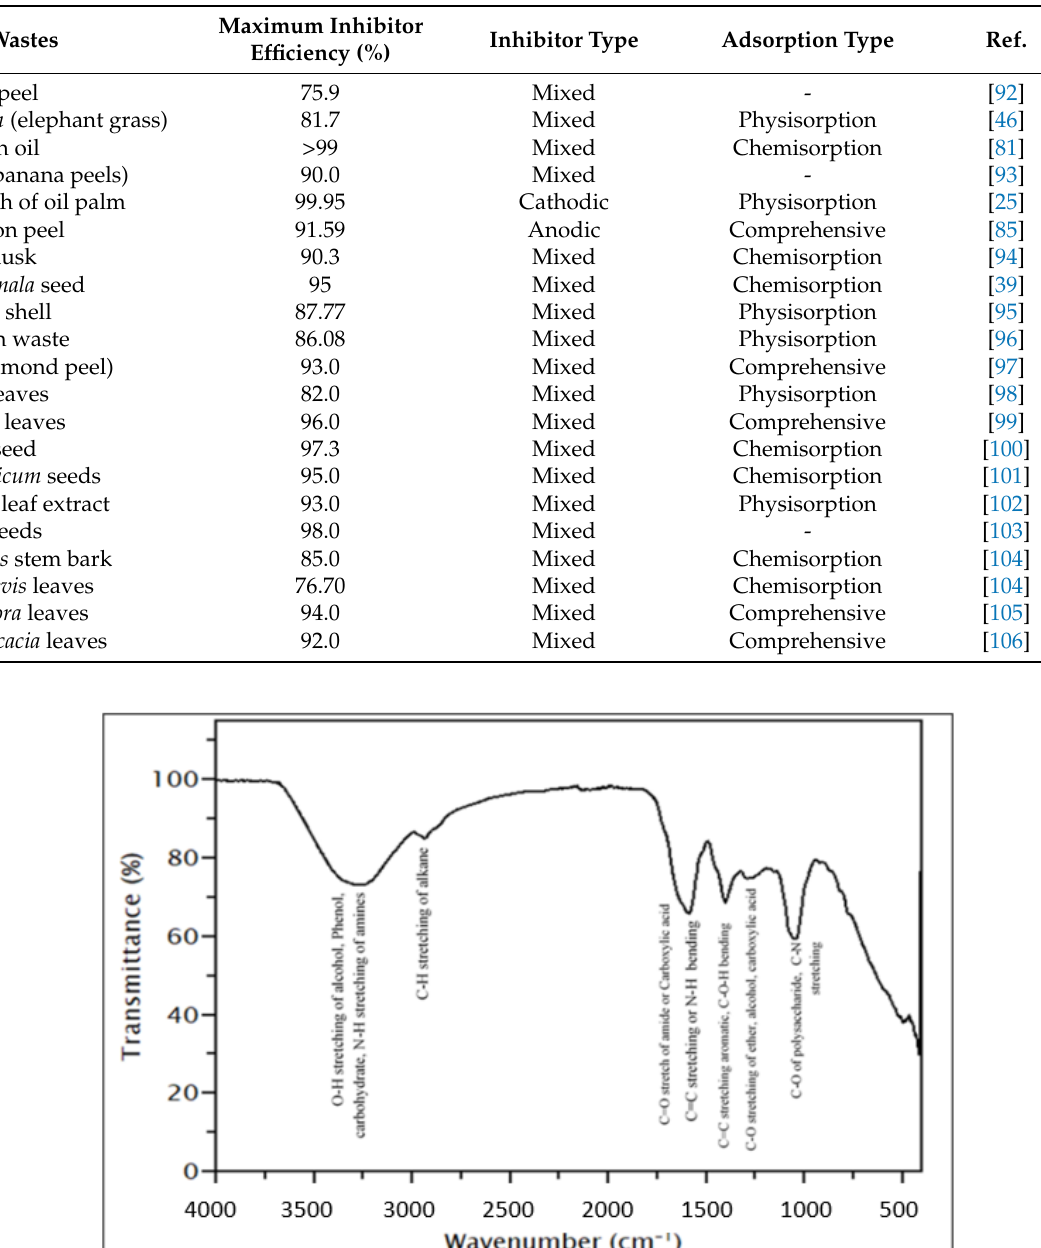
Table 4. Past research concerning biomass waste-based organic corrosion inhibitors.